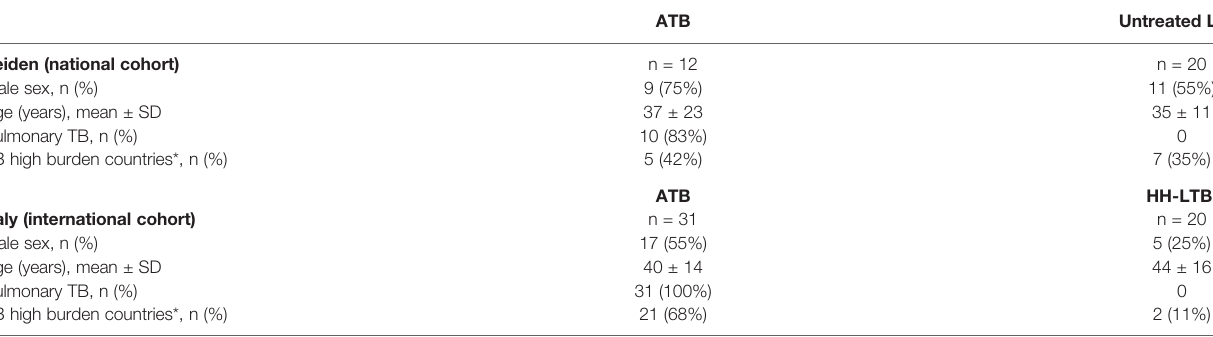
TABLE 2 | Baseline characteristics of the validation